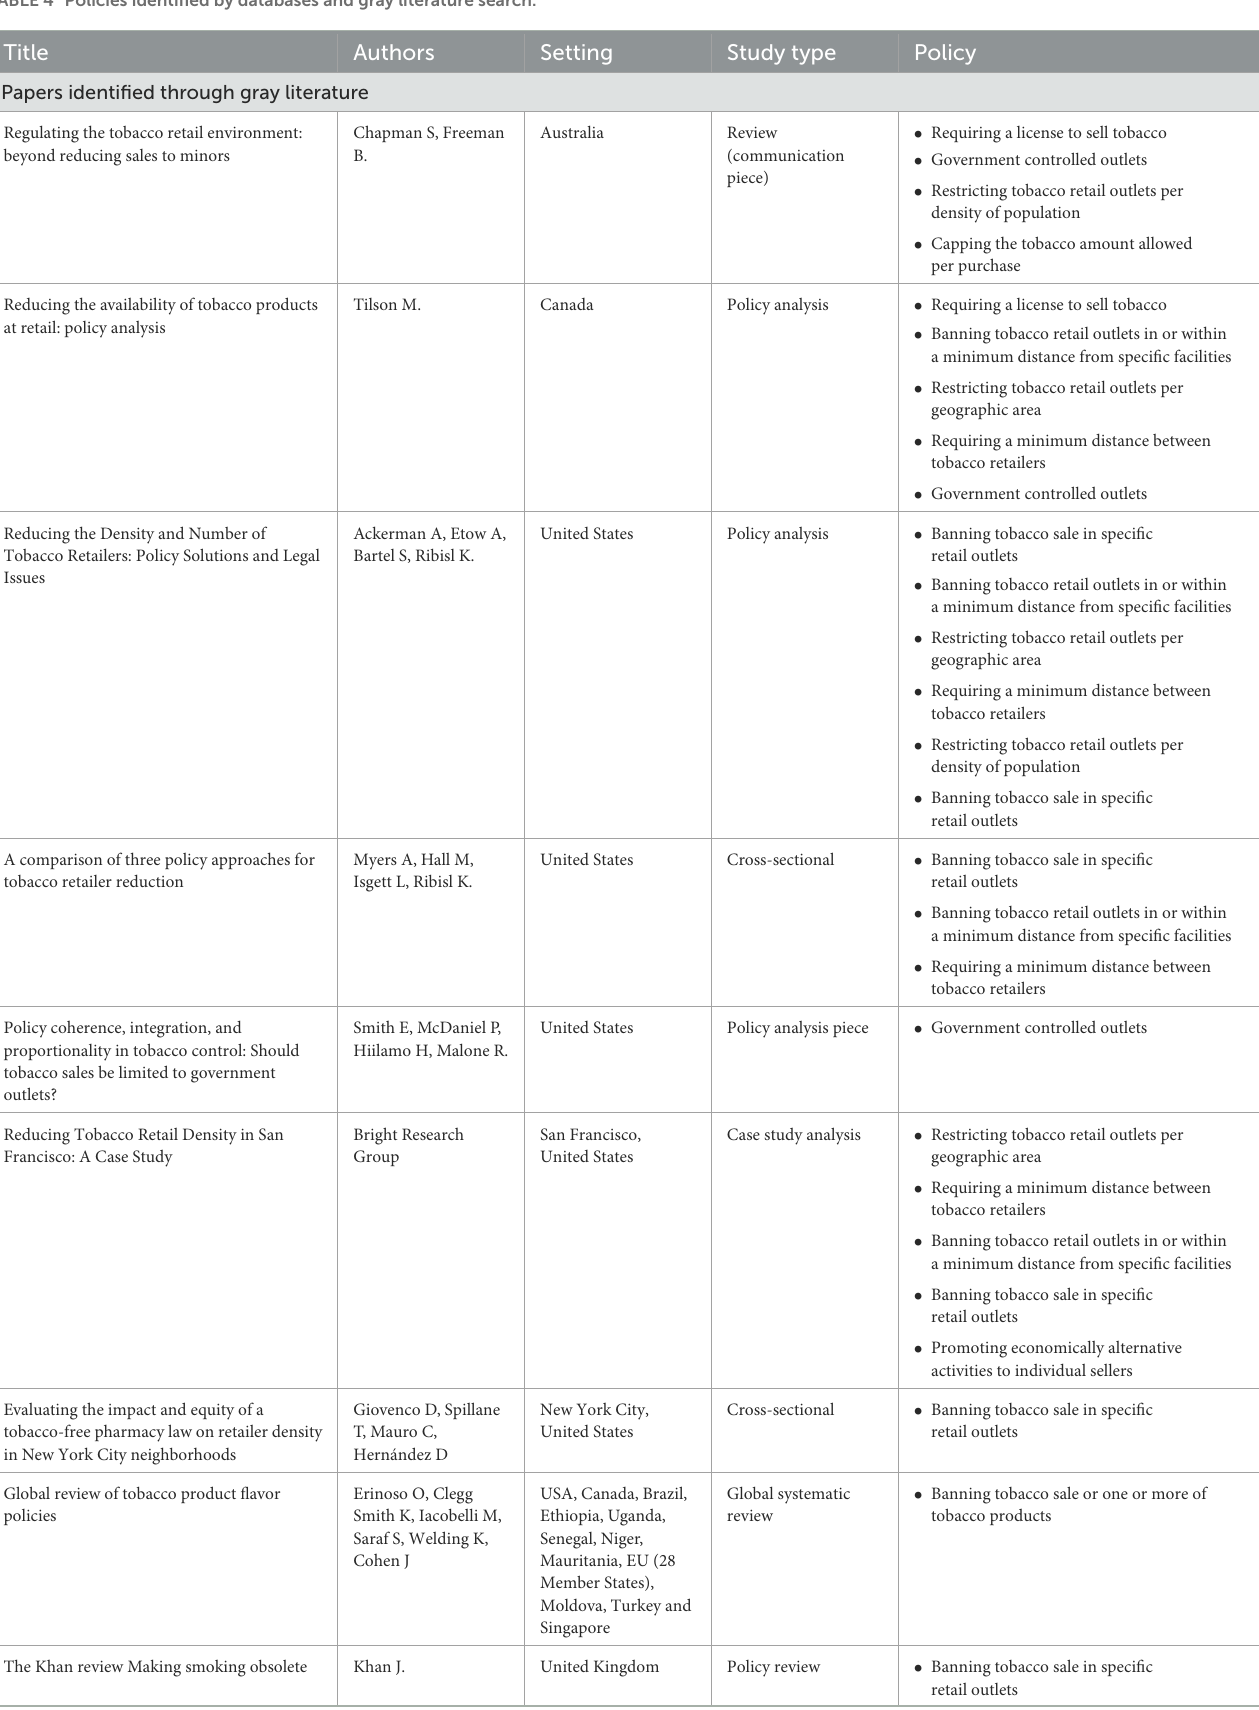
TABLE 4 Policies identified by databases and gray literature